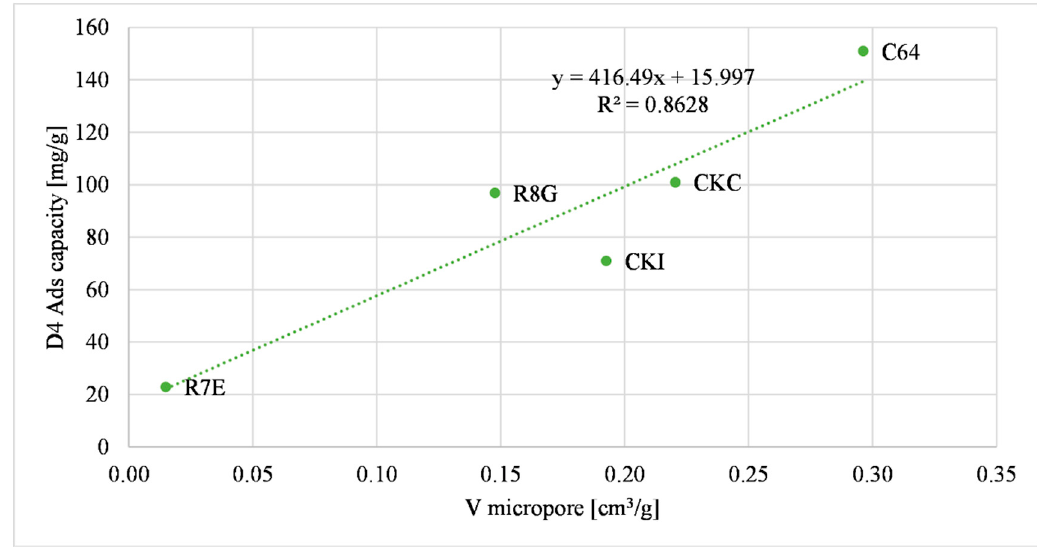
Figure 4. Micropore volume correlation with D4 adsorption capacity.